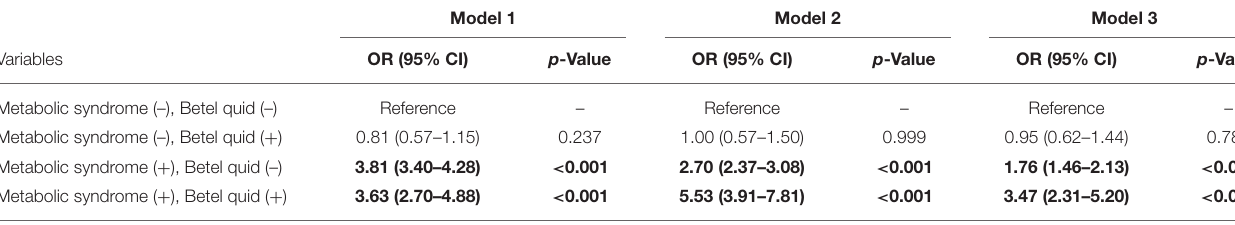
TABLE 2 | Logistic regression model for risk of significant liver fibrosis (defined as NFS ≥ -1.455).